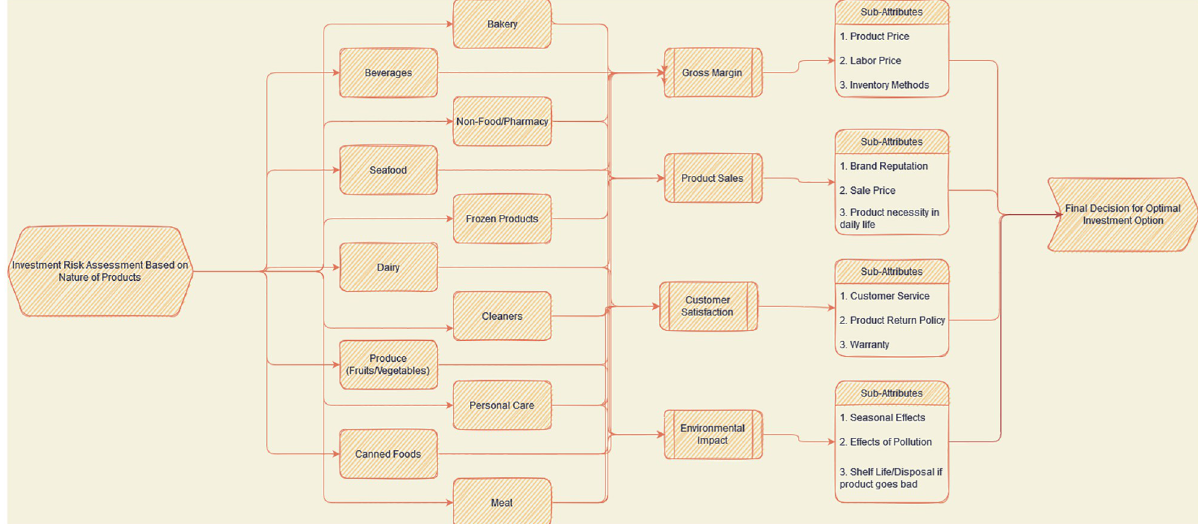
Fig 19. Factors considered for the risk assessment for supermarket products.